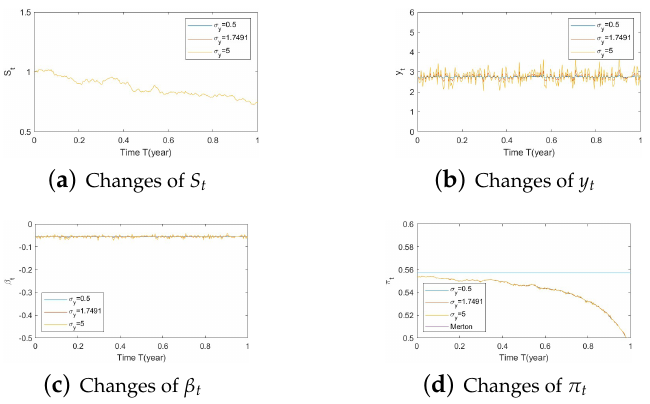
Figure A15. Illustrate the impact on ( a ) stock prices, ( b ) driver of elasticity, ( c ) elasticity of volatility, and ( d ) optimal stock allocations when varying σ y ( e . g ., σ y = 0.5,1.7491,5 )